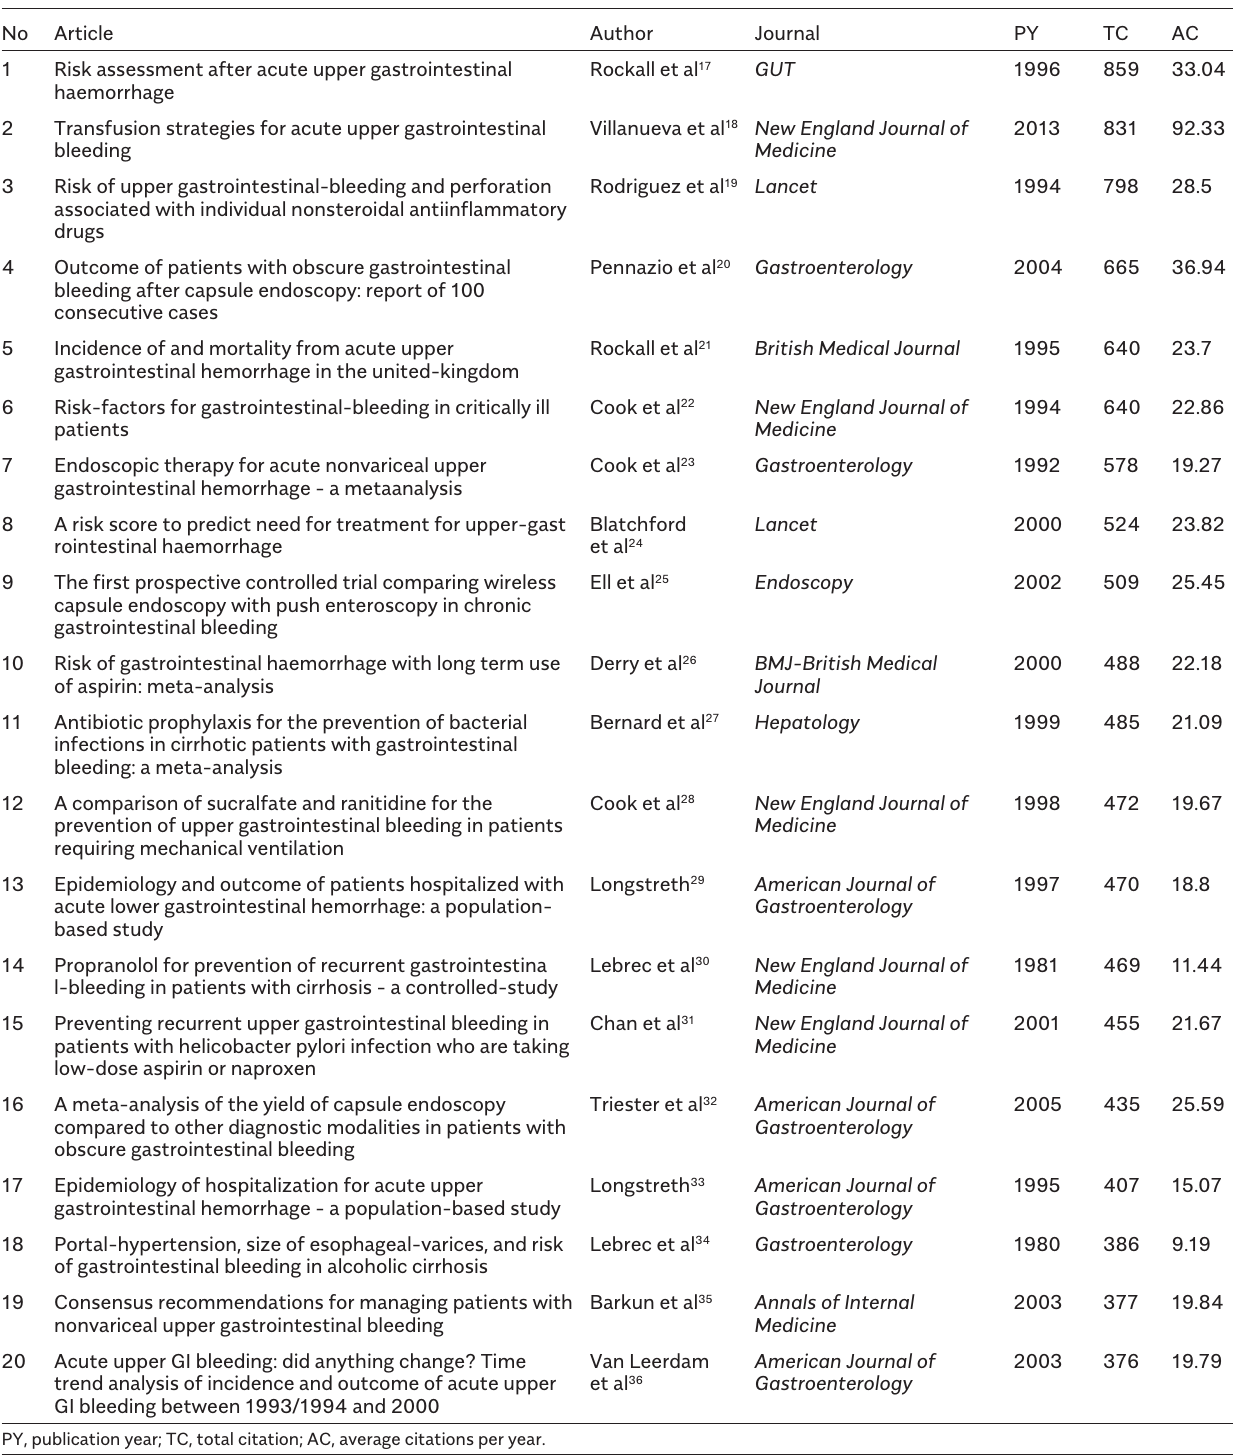
Table 2. Top 20 Most Cited Articles According to Total Citations on Gastrointestinal